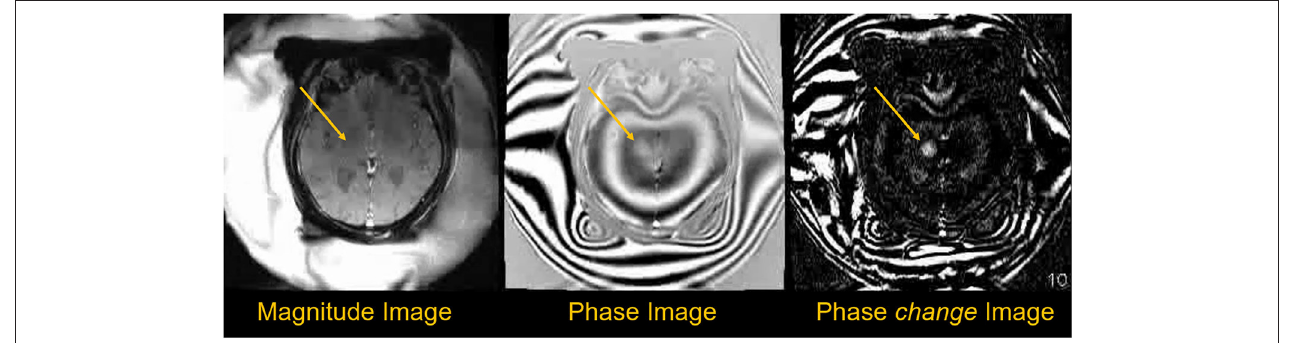
FIGURE 5 | Phase data used to obtain temperature information during sonication. The magnitude image shows little change during treatment, but the phase images show more measurable changes. Temperature difference maps ( 1 T) can be created using phase-change images obtained every ∼ 6s during treatment, with temperature changes proportional to cumulative phase shift (35).